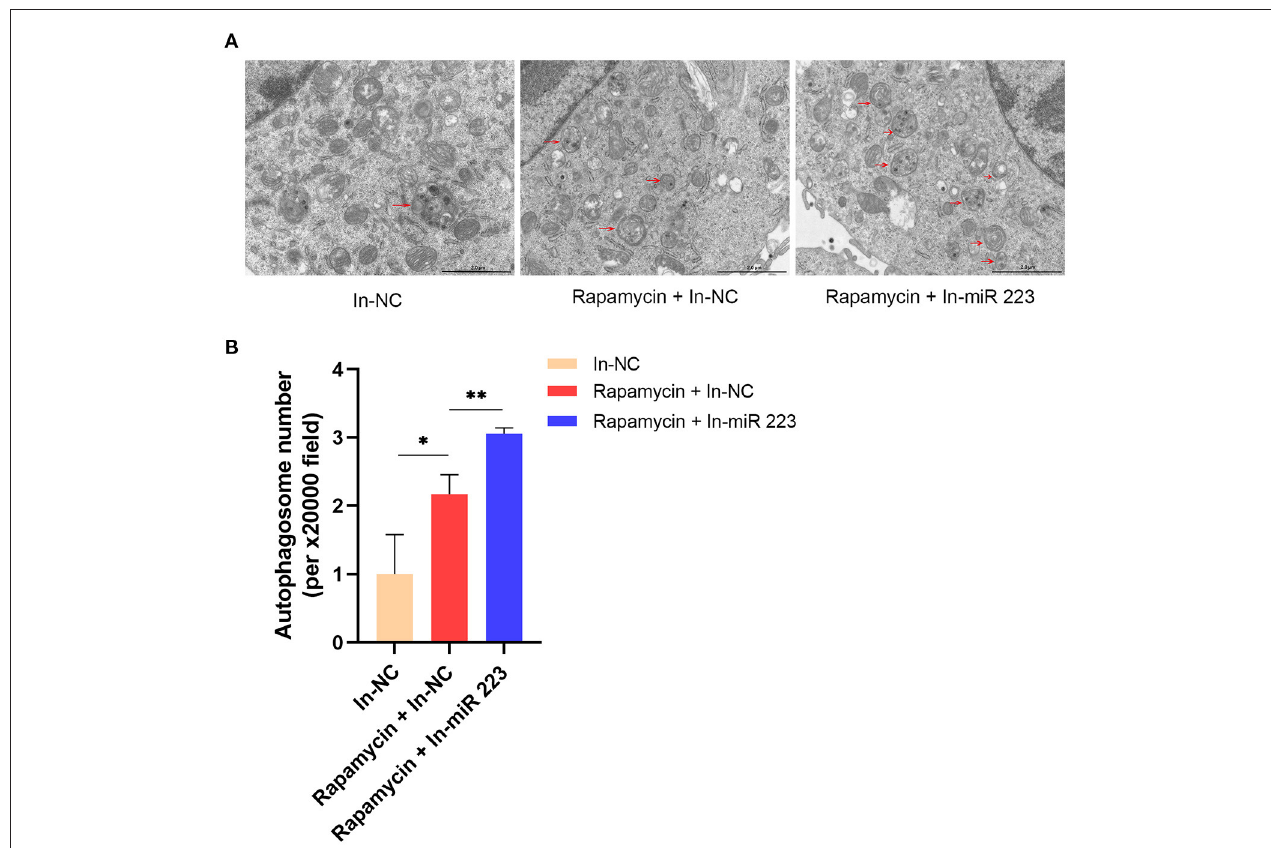
FIGURE 7 | Inhibition of miR 223 increased autophagy in BV2 cells. (A) Inhibition of miR 223 induced increased autophagy in BV2 cells upon Rapamycin stimulation. (B) Quantitative analysis of autophagosome number. Statistically significant differences were determined using the unpaired t -test. Data are presented as means ± SD ; * p < 0.05; ** p < 0.01. Scale bars: 2.0 µ